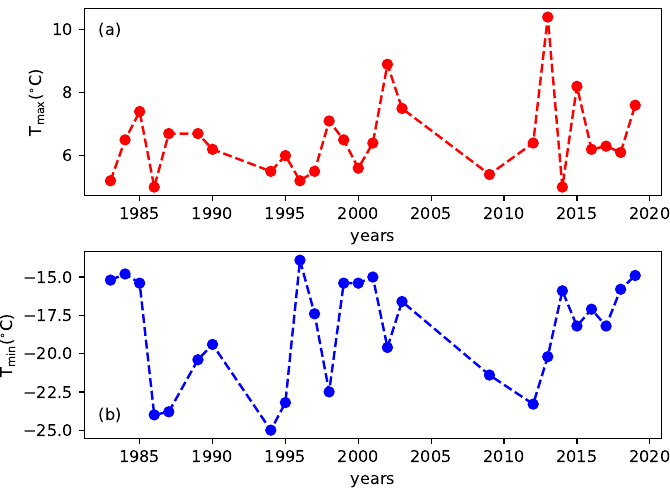
Figure 7. Annual maximum ( a ) and minimum ( b ) temperatures at Arturo Prat Station.